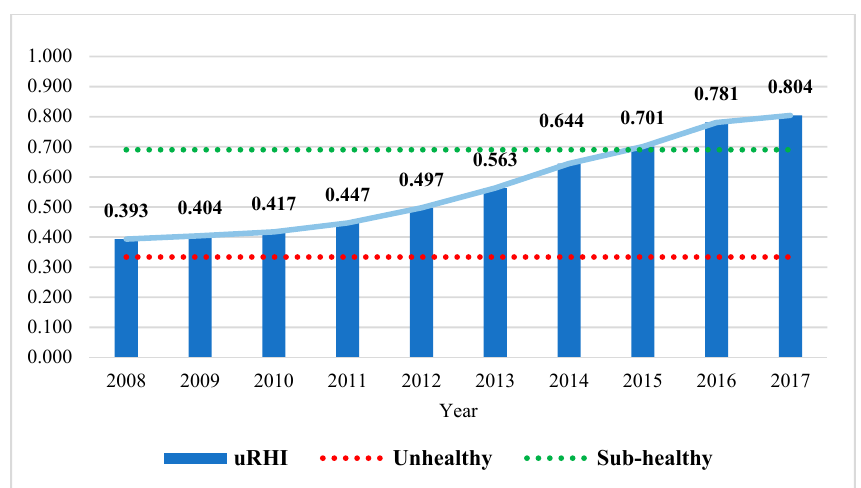
Figure 3. The urban river health index ( uRHI ) trend of Jialu River from 2008 to 2017.